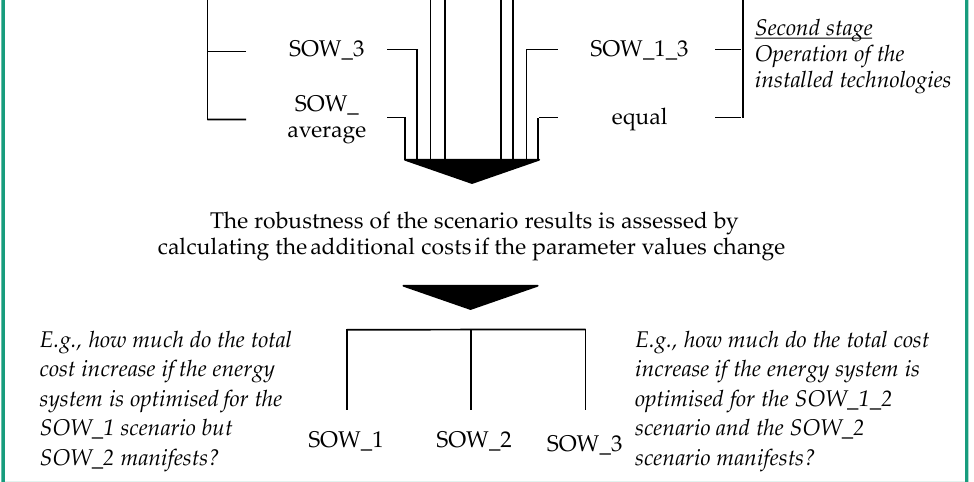
Figure 6. Process to compare the optimisation results (uncertain CO 2 prices and energy carrier cost).